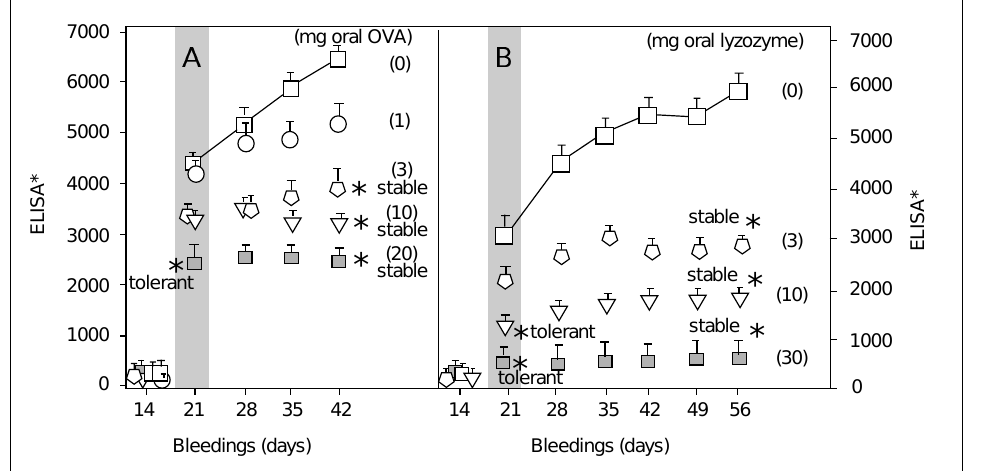
Figure 3 - Stabilization of serum antibody responses with differ- ent doses of fed antigen. A , Mice received a single gavage with saline (controls, open squares) or saline containing either 1 mg (circles), 3 mg (pentagons), 10 mg (triangles) or 20 mg OVA (filled squares), 7 days before pri- mary ip immunization with 10 µg OVA + 1 mg Al(OH) 3 ip ; 14 days later a series of 4 ip weekly chal- lenges with 3 µg soluble OVA was initiated. The gray area high- lights secondary responses to OVA. B , A similar experiment performed using lysozyme as the antigen. Asterisks indicate significant differences between control and experimental